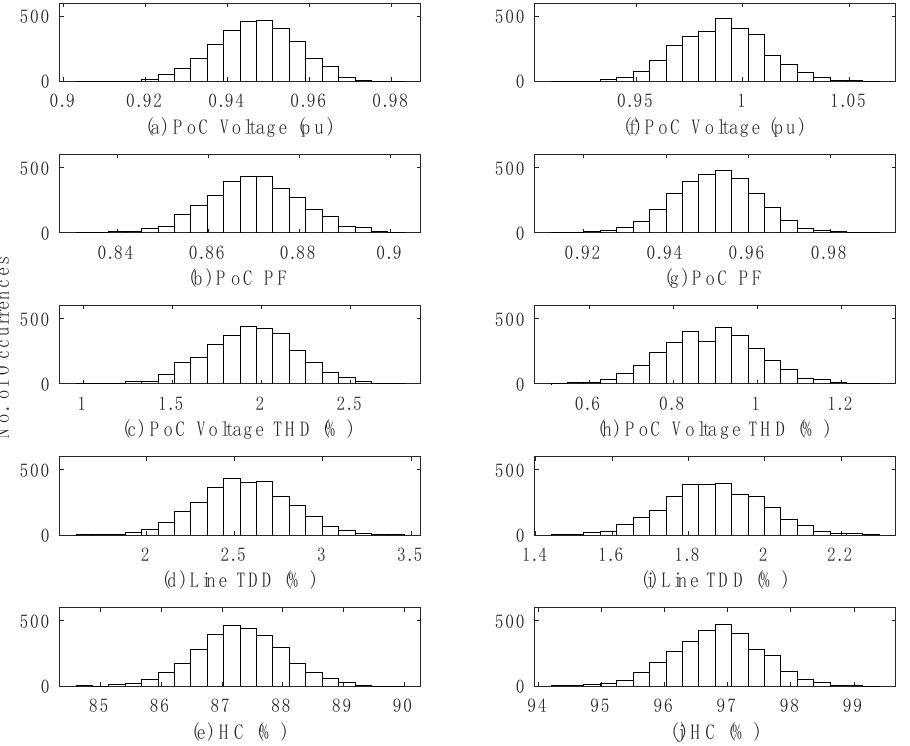
Figure 13. System performance parameters obtained from the developed MCS-based method prior to ( left ) and after ( right ) installing the PPF.